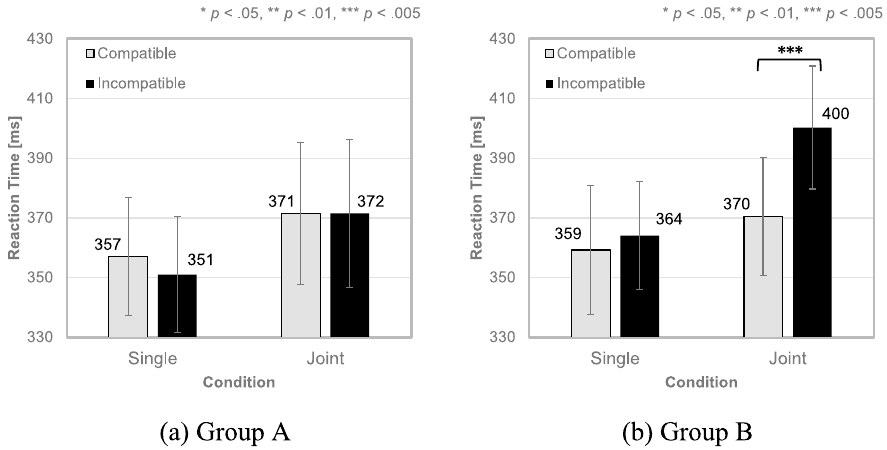
Figure 5. Mean Experiment 1 reaction times (RTs) for ( a ) group A (diotic, n = 8) and ( b ) group B (binaural, n = 8) under Single and Joint conditions. Error bars indicate standard errors of the